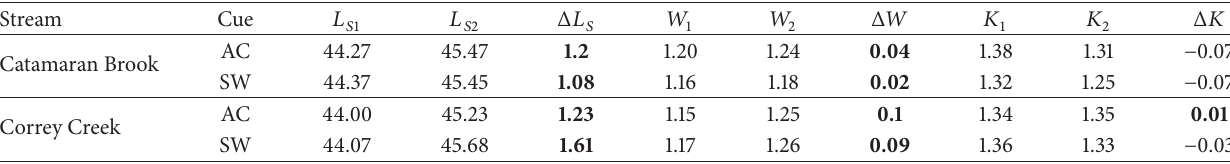
Table 3: Mean values of fish size and Fulton’s condition index ( 𝐾 ) of 0 + Atlantic salmon ( Salmo salar ) at the beginning and end of captive cross-population transplants 1 . Positive differences are indicated in bold